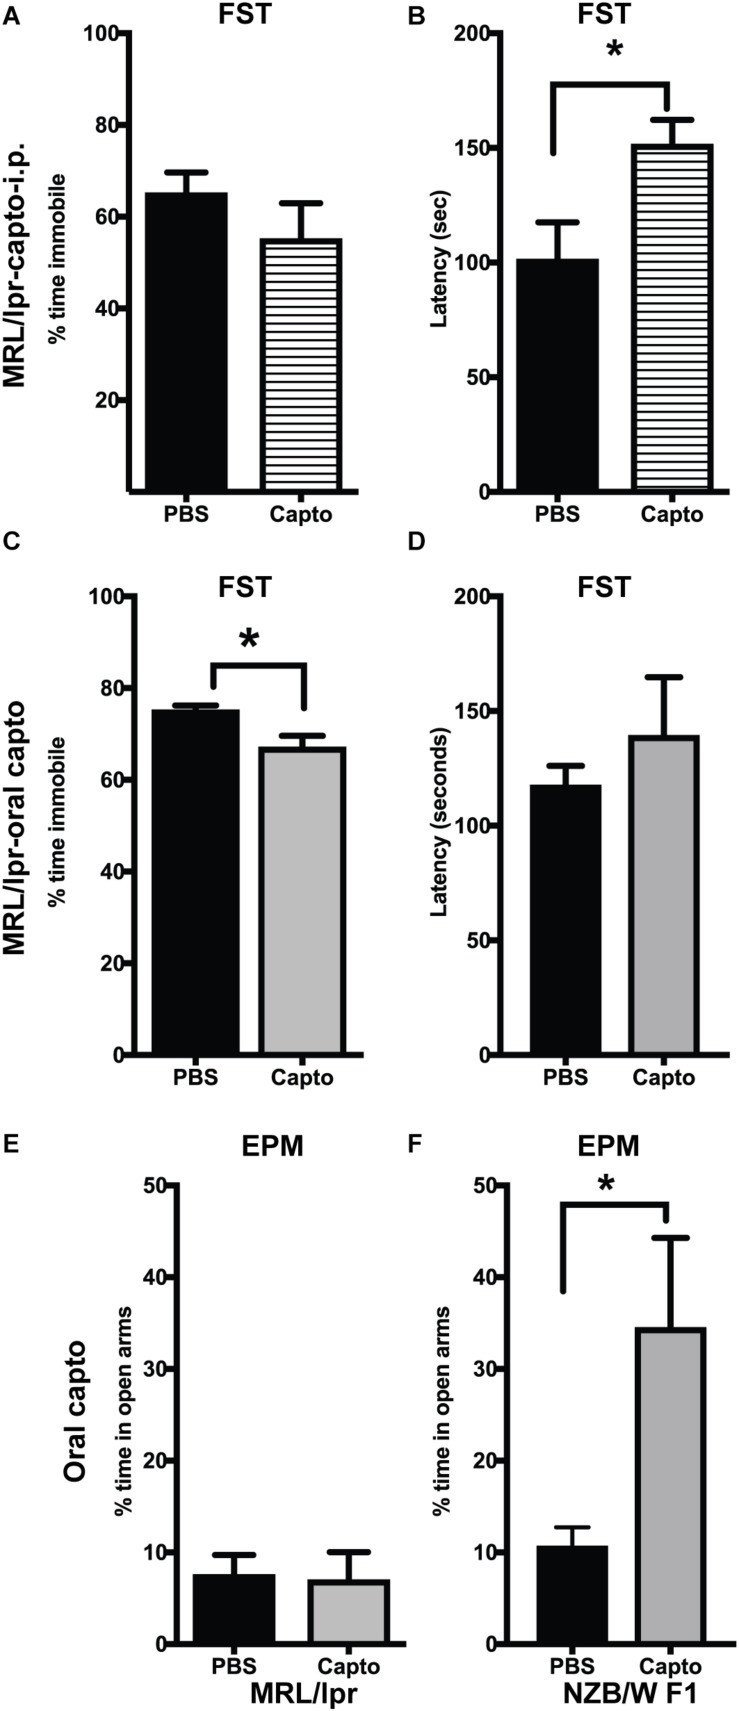
Captopril suppresses depression-like and anxiety-like behavior in lupus-prone mice. The forced swim test was performed in MRL/lpr mice after systemic captopril administration (A,B) and oral captopril administration (C,D) as described in the Methods section. Percent time immobile is represented in (A,C). Average latency to immobility (in seconds) is represented in (B,D). Captopril mice showed shorter time of immobility and longer latency indicating less depressive behavior than the untreated controls. Anxiety-like behavior was measured by EPM in the MRL/lpr (E) and NZB/W F1 (F) mice. Percent time spent in the open arms is shown. Captopril treated NZB/W F1 mice spent more time in open arms indicating less anxious behavior compared to PBS treated controls. Data are shown as mean + SE. Students t test *p < 0.05, n = 6/group.